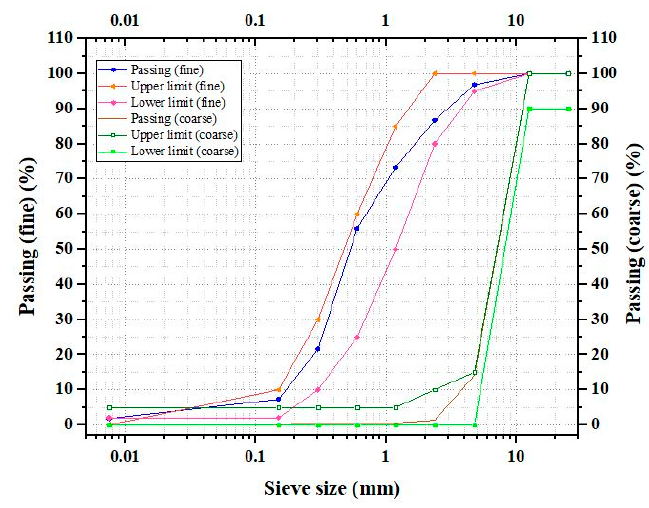
Figure 2. Aggregates size distribution.